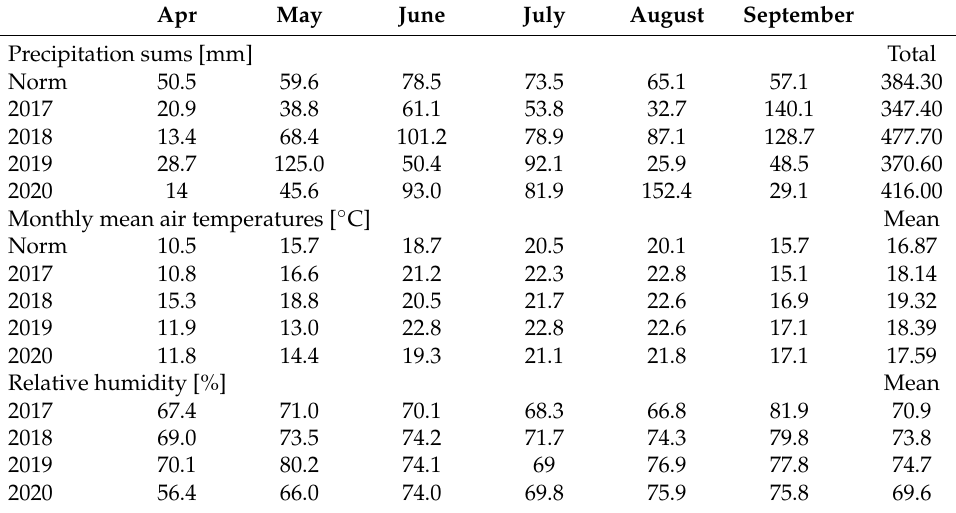
Table 1. Meteorological variables, monthly mean temperatures, relative humidity, vapor pres- sure deficits and monthly precipitation sums measured at Agrometeorological Research Station of Keszthely in the growing seasons 2017–2020. The climate norm represented the period between 1971 and